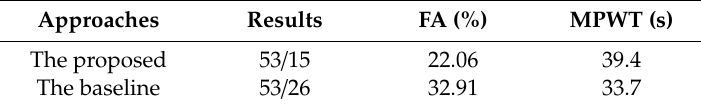
Figure 16. The positional offsets of the predicted trajectory for a decelerating flight (up: X dimension; down: Y dimension; the dots in a different color are extracted from historical trajectories). Table 1. Experimental results for conflict